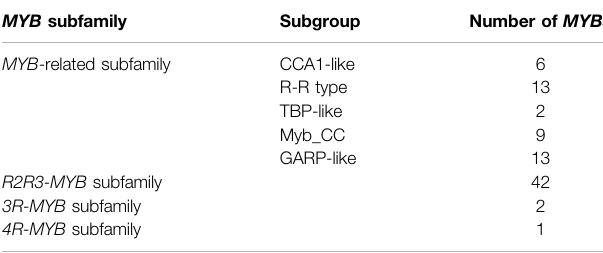
TABLE 1 | Summary of the total identi fi ed CwMYBs in C. wenyujin